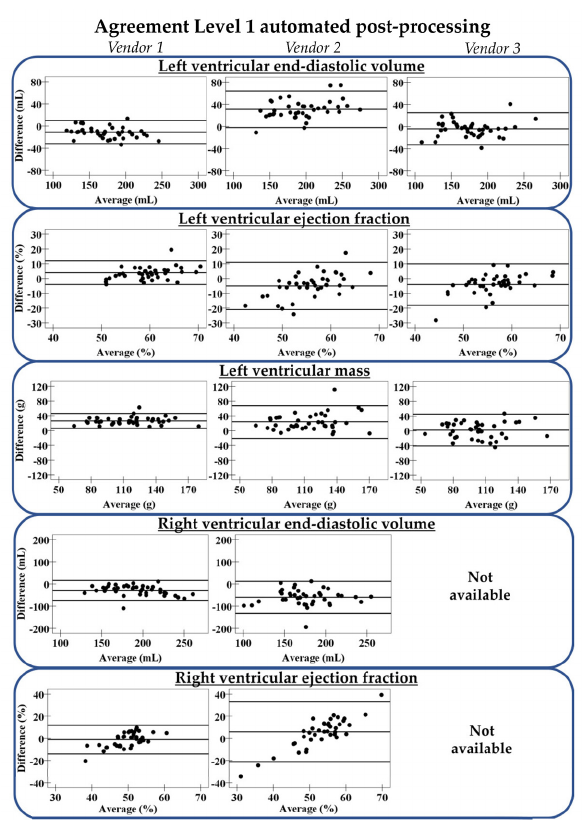
Figure 3. Agreement between Level 1 automation and gold standard manual contour-tracing. The three lines represent mean difference with limits of agreement. Vendor 3 does not support automated right ventricular